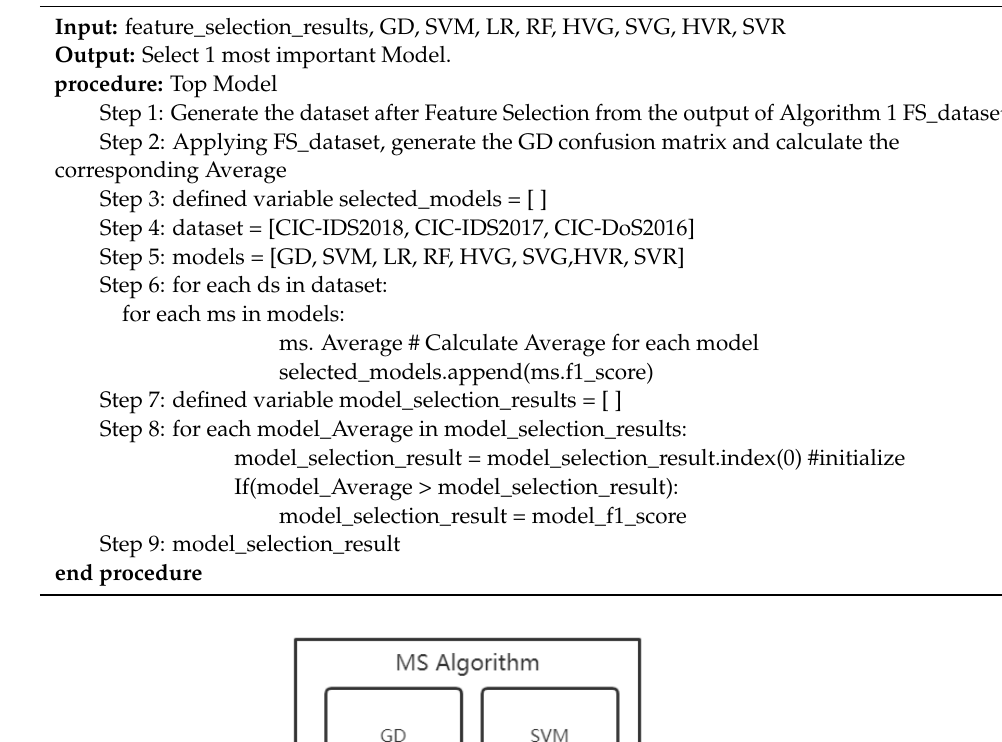
Algorithm 2 : Model Selection Algorithm